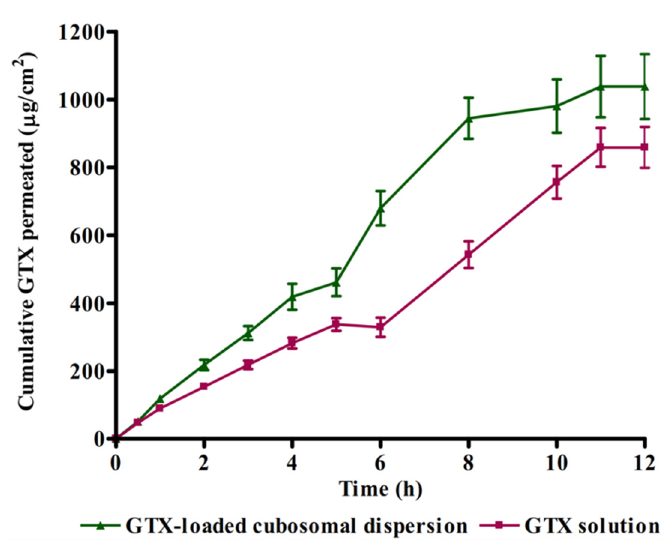
Figure 3. Comparison between rabbit corneal permeation of GTX delivered from cubosomal disper- sion and aqueous GTX dispersion.